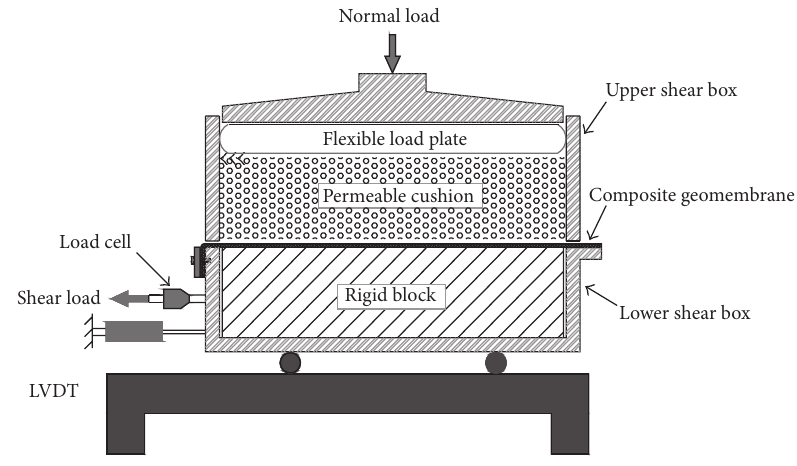
Figure 1: Schematic diagram of interface shear